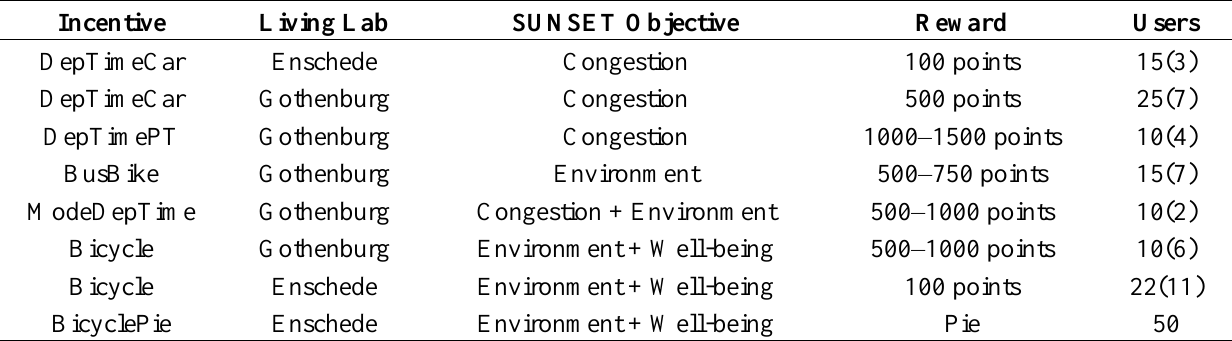
Table 6 . Summary of different types of incentive challenge issued during the LL evaluations and the proposed points reward for meeting the challenge (The two numbers of users are the number who participated in the challenge, with the number who met the challenge given in